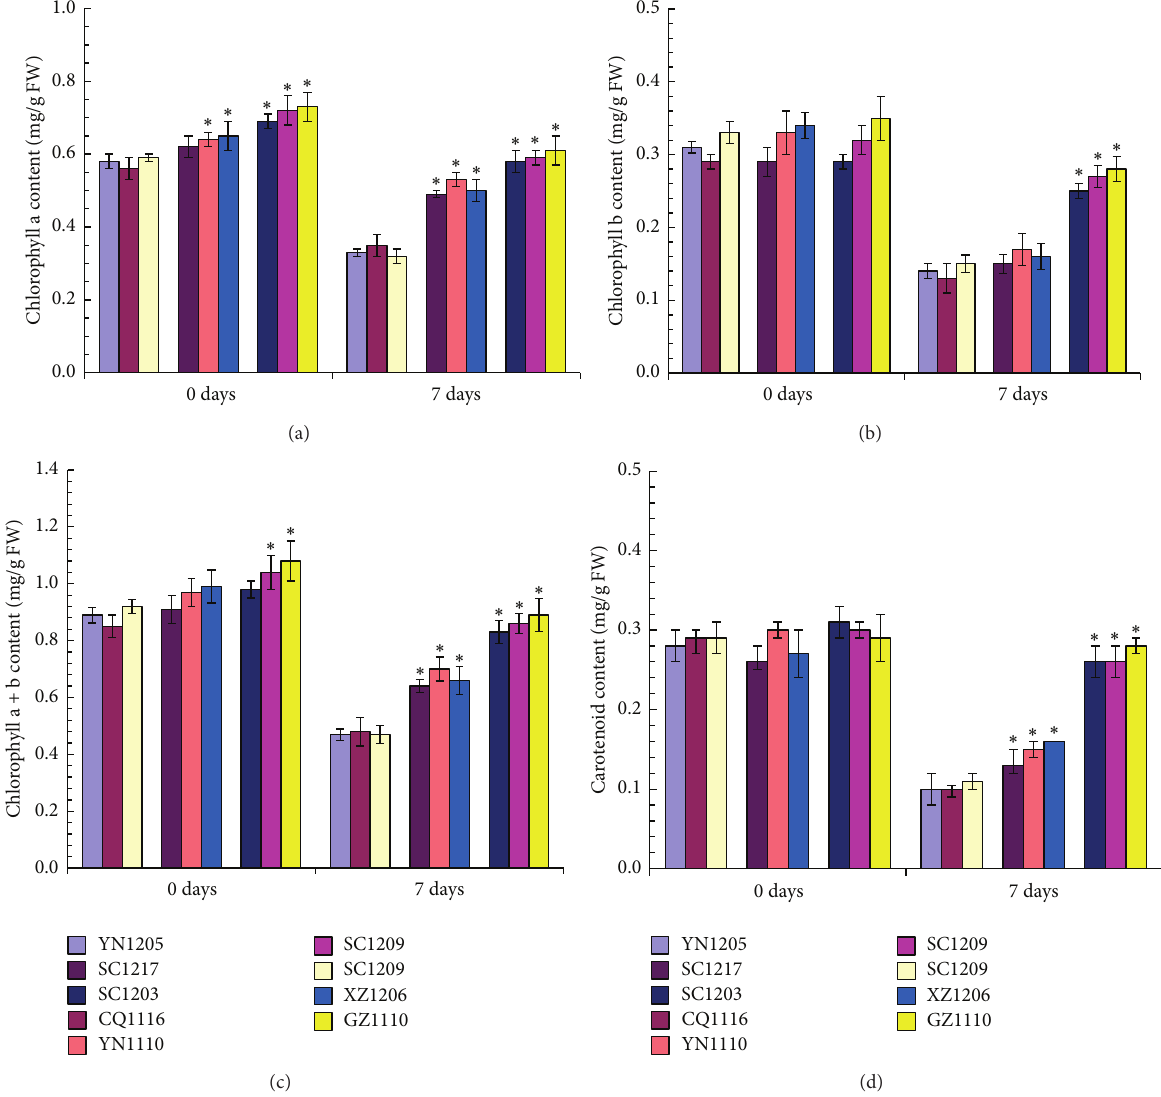
Figure 4: Comparison of chlorophyll a (a), chlorophyll b (b), total chlorophyll (c), and carotenoid (d) in leaves from nine selected C. dactylon accessions in response to SO 2 stress. Mean values are presented with vertical error bars representing the standard deviations ( 𝑛 = 3 ). The asterisk symbols indicate significant differences between SO 2 -sensitive accessions and SO 2 -tolerant